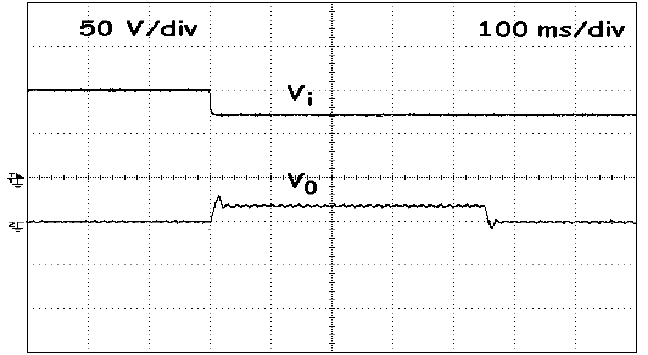
Figure 23. Experimental results for the voltage across the diodes D 2 and D 3 in boost mode.